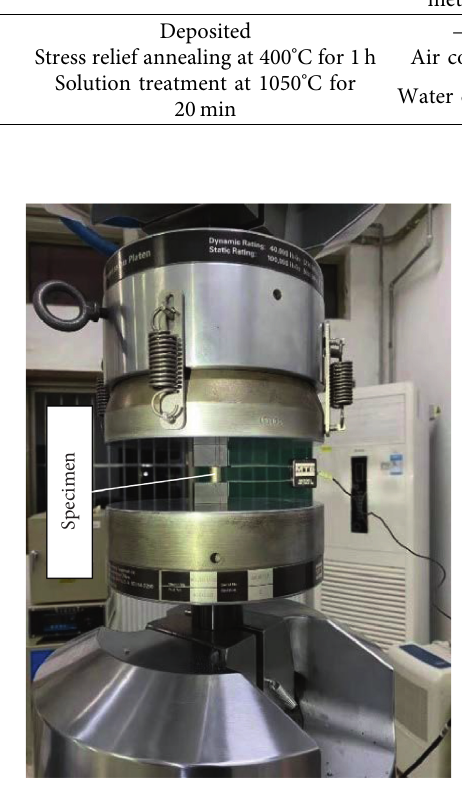
Figure 3: Quasistatic compression